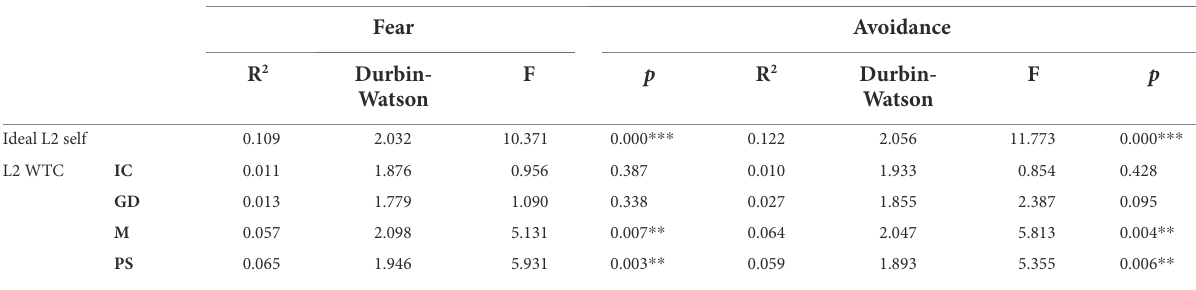
TABLE 2.1 Multiple regression analyses (Social phobia as independent